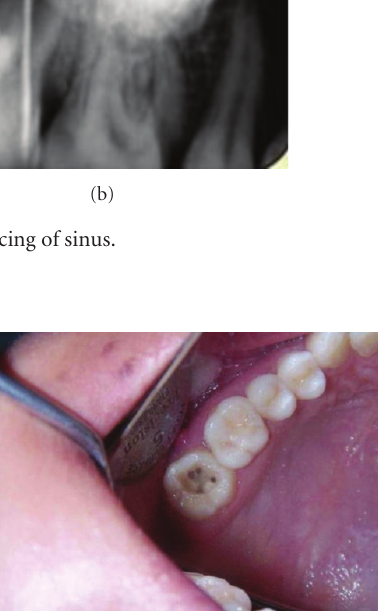
Figure 3: Clinical examination showing 4 root canal orifices: 2 located buccally and 2 palatally (mirror